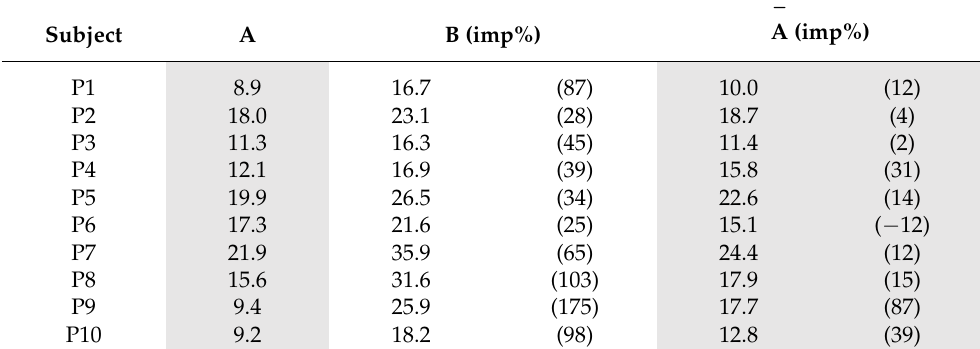
Table A1. Pelvic rotation from the clinical NDT rehabilitation by therapists.